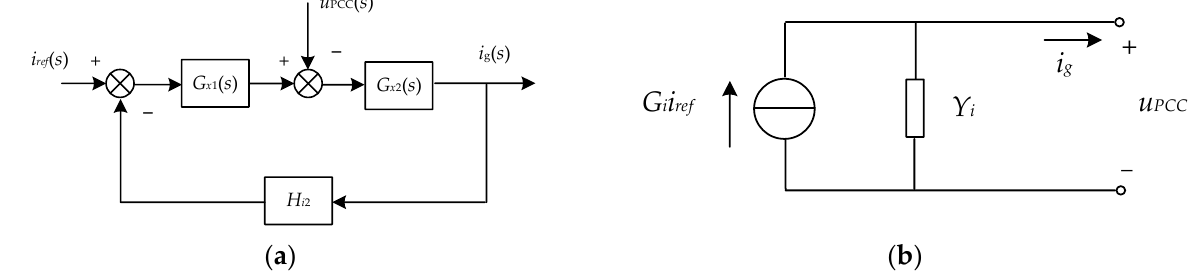
Figure 4. The establishment of the Norton Equivalence Model: ( a ) Equivalent transformation of the mathematical model; ( b ) The Norton two-port equivalent model.